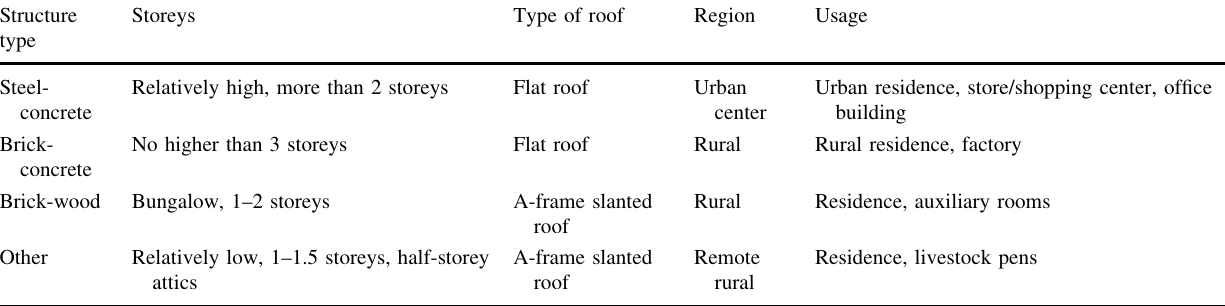
Table 2 Characteristics of various building structure types in China Structure